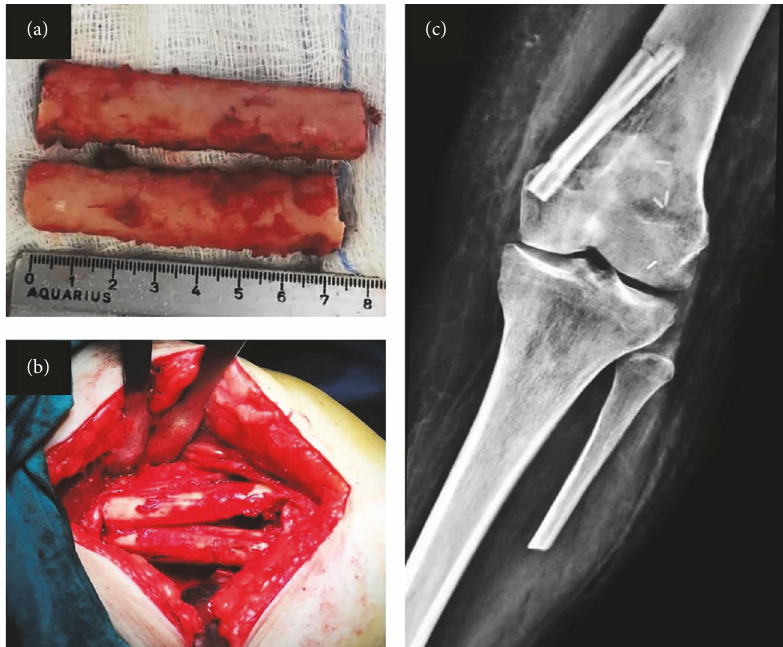
Figure 10: (a) Autograft from the contralateral fibula was used and was cut in the longitudinal axis. (b) Two pieces of hemicortical fibula were inserted to the posterior-medial part of the distal femur after excision of the PMMA. (c) Postoperative anteroposterior radiographs of the knee showing the fibula autografts in